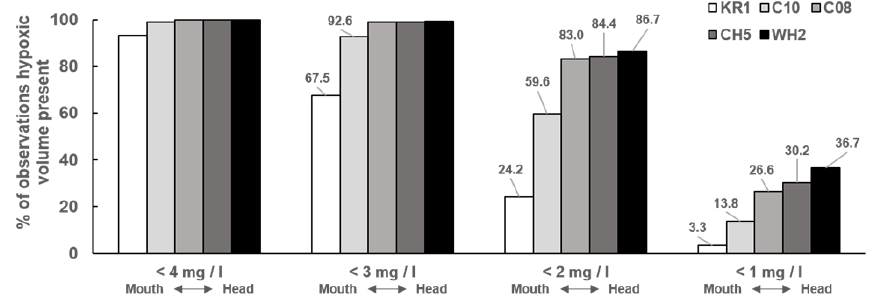
Figure 6. Percentage of total observations where monthly sonde profiles contained dissolved oxygen measurements less than 4, 3mgL − 1 ,